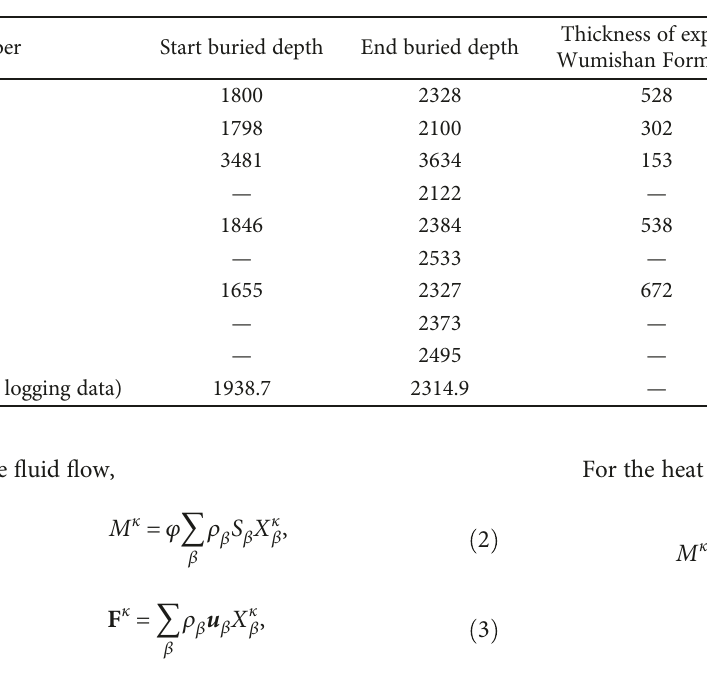
Figure 1: (a) Location of the Wumishan geothermal reservoir, Tianjin, China, (b) stratigraphy in the research area, and (c) the position of existing boreholes in the model Table 1: Permeability and porosity measured in 9 wells.